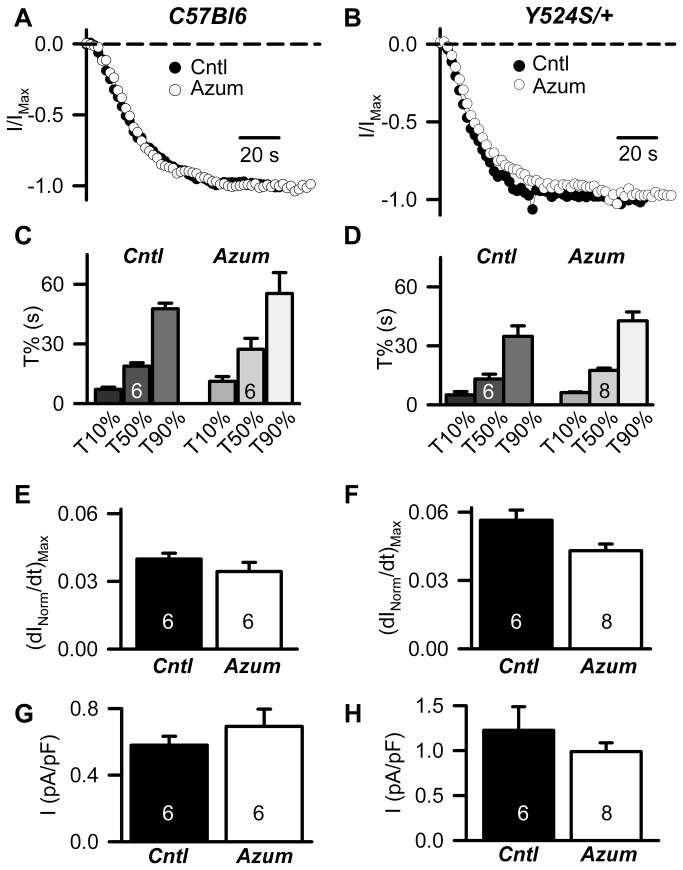
Azumolene pretreatment does not alter ISCRAC magnitude or rate of activation in myotubes from WT C57Bl6 and Y524S/+ mice.(A and B) Representative time courses for activation of normalized ISkCRAC (I/IMax) recorded from WT C57Bl6 (A) and Y524S/+ (B) myotubes in the absence (filled circles) and presence (open circles) or 50 µM azumolene (Azum). (C and D) Average (±SE) time required for 10% (T10%), 50% (T50%), and 90% (T90%) activation of ISkCRAC in WT C57Bl6 (C) and Y524S/+ (D) myotubes in the absence (left) and presence (right) or 50 µM azumolene. (E and F) Average (±SE) maximum rate of ISkCRAC activation determined from the peak of the first derivative of the I/Imax time course ((dINorm/dt)max) in WT C57Bl6 (E) and Y524S/+ (F) myotubes in the absence (left) and presence (right) or 50 µM azumolene. (G and H) Average (±SE) peak ISkCRAC current density recorded at -80 mV in WT C57Bl6 (G) and Y524S/+ (H) myotubes in the absence (left) and presence (right) or 50 µM azumolene. All experiments were conducted at room temperature.